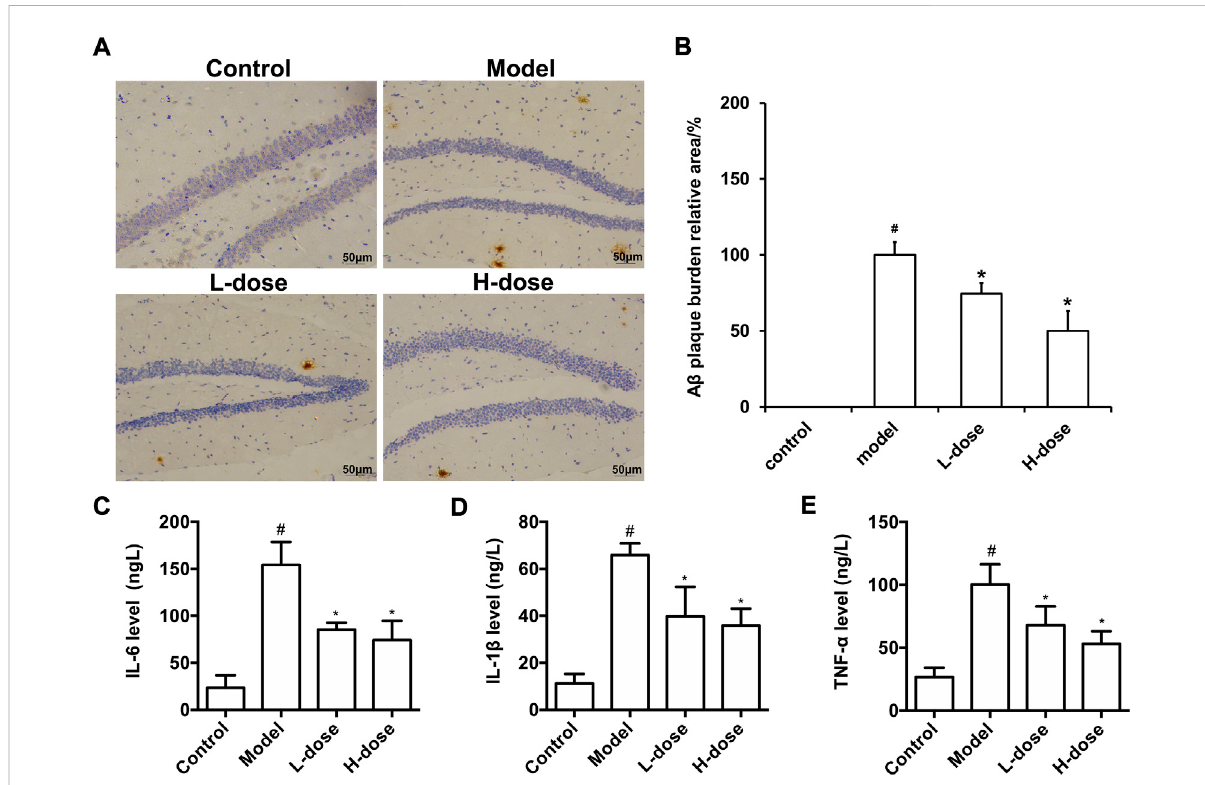
FIGURE 2 BLWE attenuated the deposition of A β and in fl ammatory response in APP/PS1 mice. A β immunoreactive plaques in the hippocampus was immunostained with anti-A β monoclonal antibody (A) , Scale bar = 50 μ m. ImageJ analyzed the percentage area of A β -immunoreactive plaques of each group (B) . Detection of IL-6 (C) , IL-1 β (D) and TNF- α (E) levels in brain tissue of mice in each group by ELISA kit. # p < 0.05 vs. the control group; * p < 0.05 vs. the model group. Values are expressed as the mean ± SD ( n = 6 per